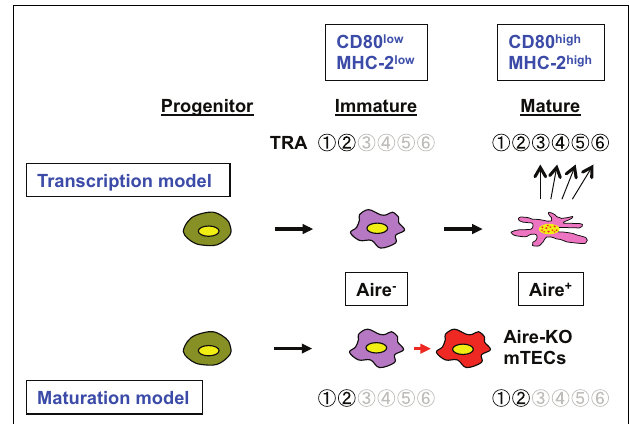
FIGURE 1 | Schematic representation of the roles ofAire inTRA gene expression associated with the mTEC differentiation program . Aire-expressing mTECs develop from their progenitor via an immature stage (CD80 low MHC-2 low ) where only limited numbers ofTRAs (e.g., 1 and 2 ) are expressed. Aire is expressed at the mature stage (CD80 high MHC-2 high ), and the transcription model (upper) suggests that Aire directly activates many targetTRA genes within mature mTECs (so-called Aire-dependentTRAs; 3 – 6 ). Consequently, lack of Aire results in defective expression of Aire-dependentTRA genes. In contrast, the maturation model suggests that Aire plays an important role in the maturation program of mTECs, and that expression of Aire-dependentTRA genes, such as 3 – 6 , can be accomplished in terminally differentiated mTECs showing a dendritic to fibroblastic morphology that have fully matured with the help of Aire. According to this scenario, lack of Aire causes a halt in mTEC maturation at a stage where promiscuous gene expression in the cells is still not possible (marked as “Aire-KO mTECs”); lack of Aire in mTECs results in premature termination of differentiation, and these CD80 high Aire-less mTECs have a more globular cell shape and lack the transcriptional machinery for Aire-dependentTRA genes (lower). Because Aire-independentTRA genes, such as 1 and 2 , can be expressed before the mature stage, lack of Aire has little impact on their